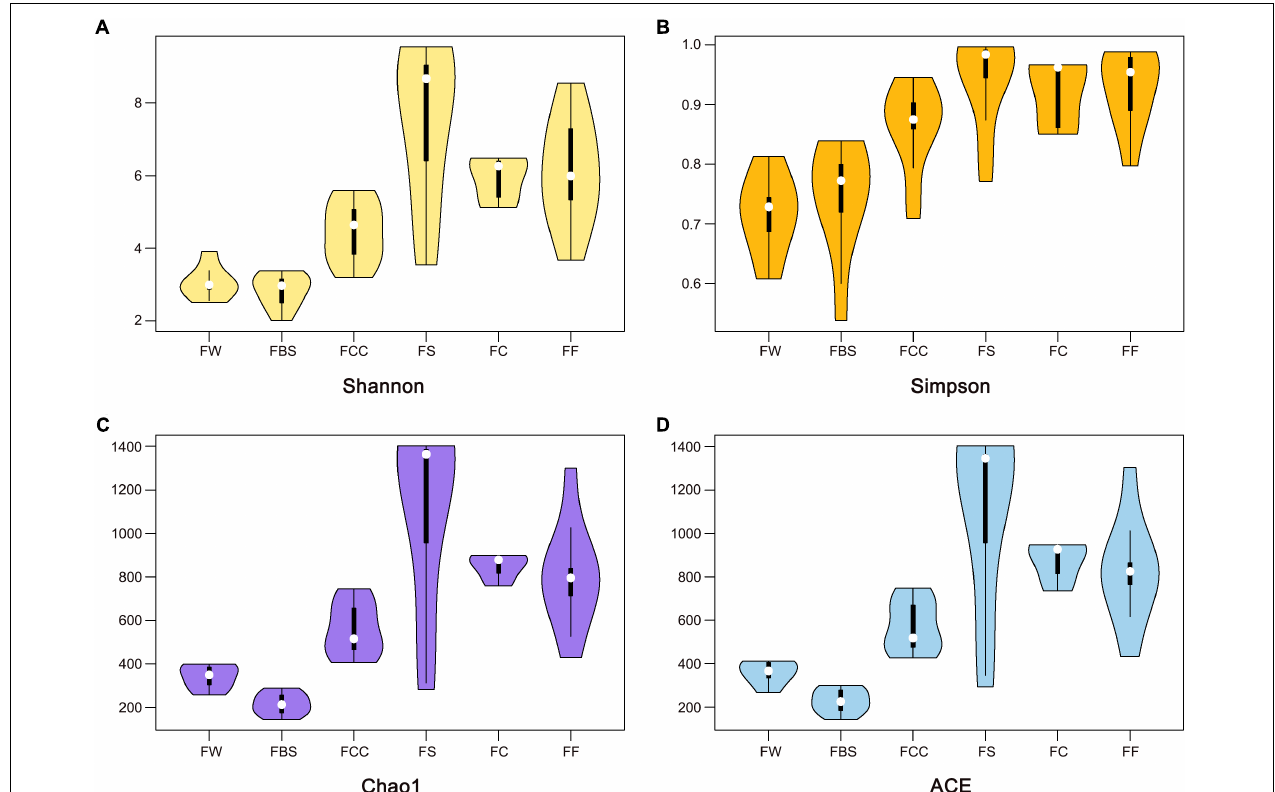
FIGURE 1 | Alpha diversity of bacterial genera using the Shannon, Simpson, Chao1, and ACE (A–D) indices.